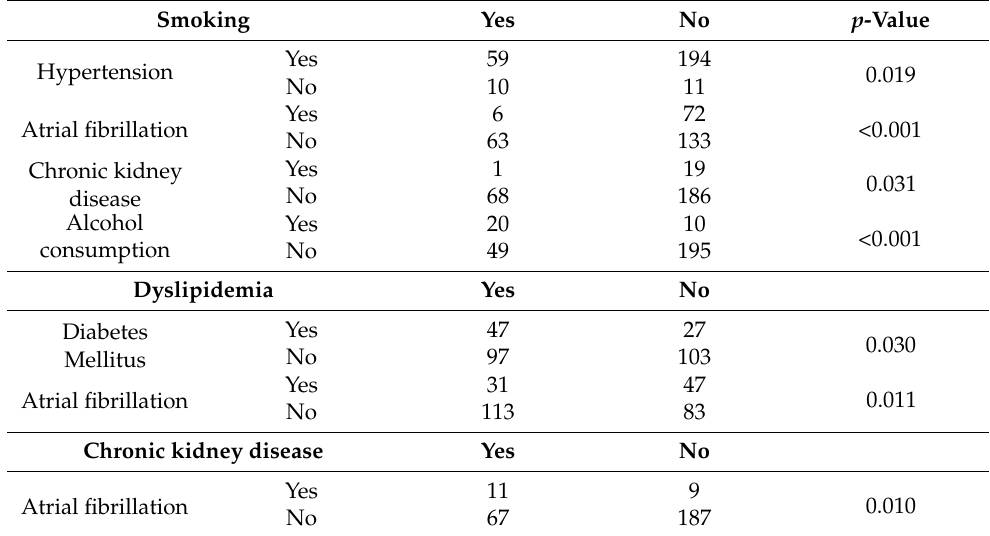
Table 4. Crosstabs between risk factors.